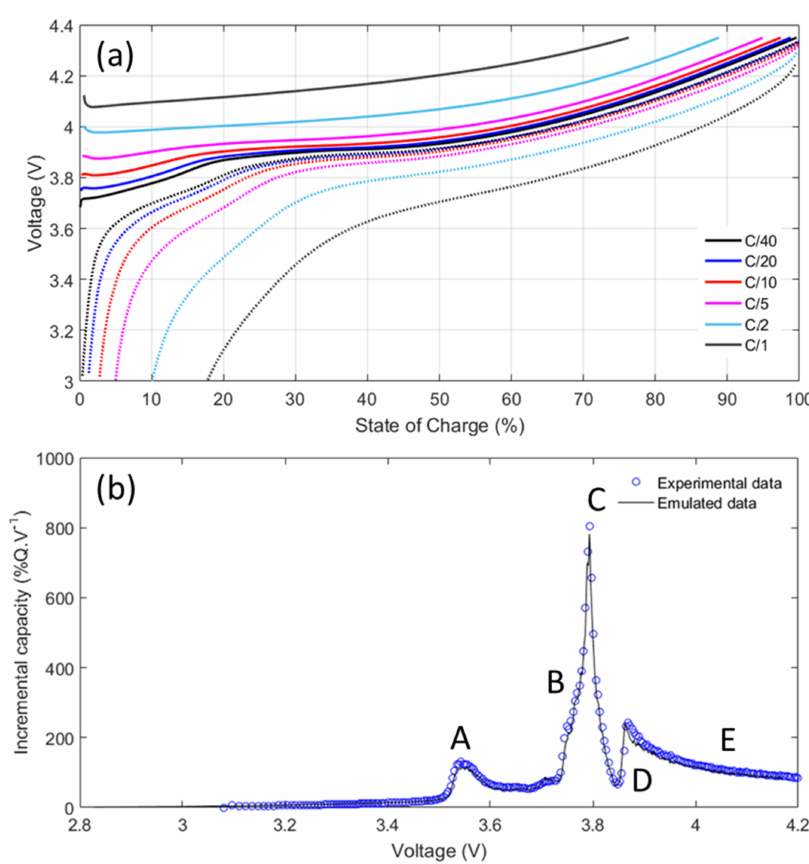
Figure 2. ( a ) Voltage vs. state-of-charge curves for the positive electrode in half cell configuration at rates ranging from C/40 to C/1 in charge and discharge; ( b ) RPT1 cell emulation using the positive electrode data and stock graphite from